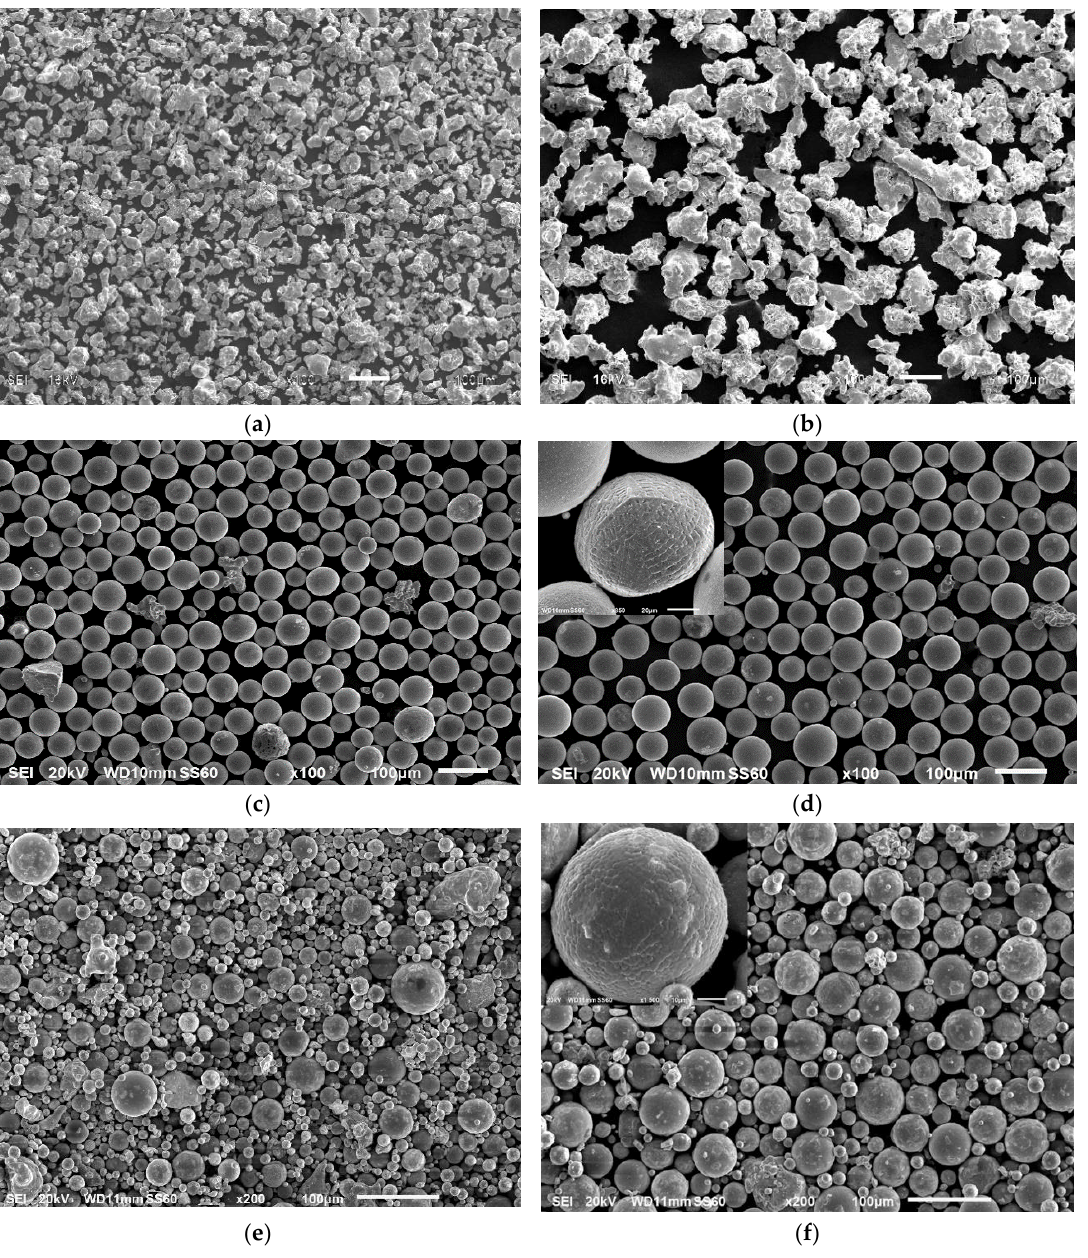
Figure 5. Low and high magnification micrographs of the AISI 304 SS powder for ( a , b ) irregular feed powder, and products after the plasma spheroidisation from the ( c , d ) catch-pot and ( e , f ) reactor walls for the −63 µm and +63–106 µm size distributions.